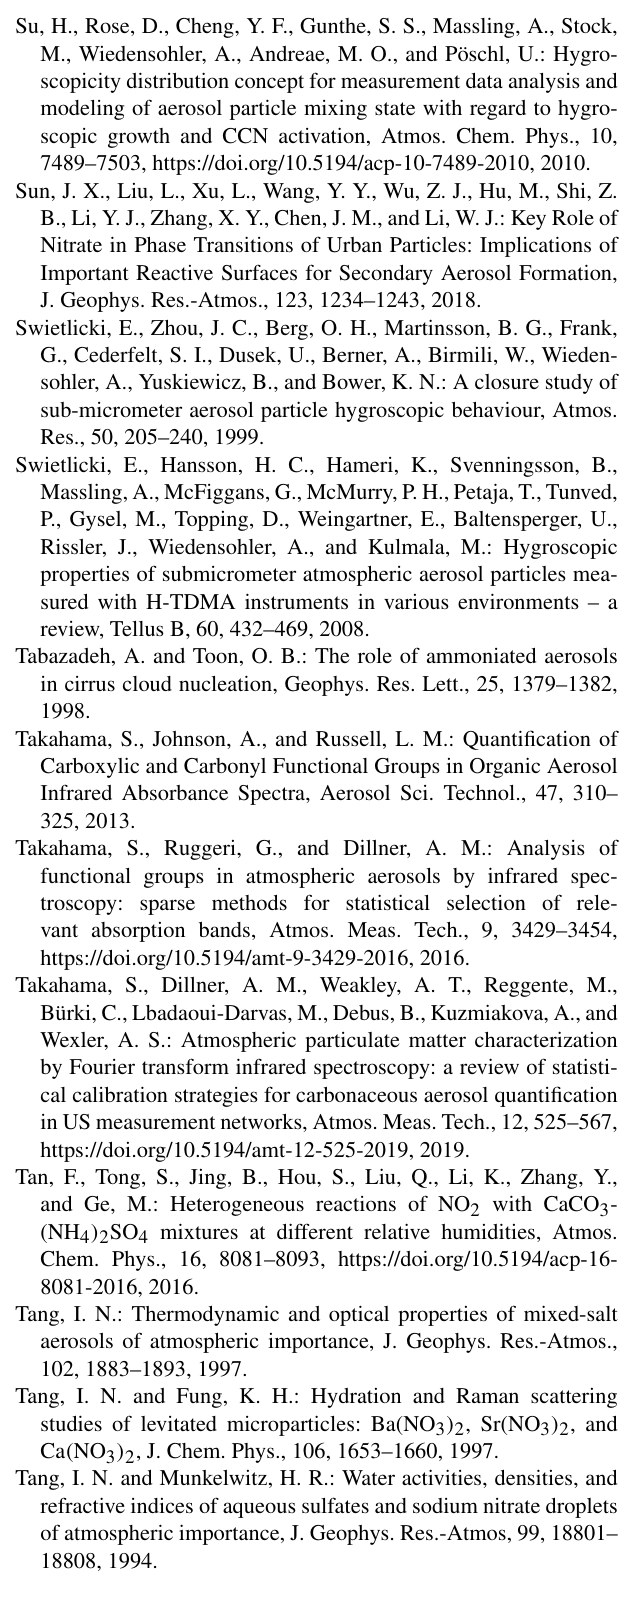
Tabazadeh, A. and Toon, O. B.: The role of ammoniated aerosols in cirrus cloud nucleation, Geophys. Res. Lett., 25,